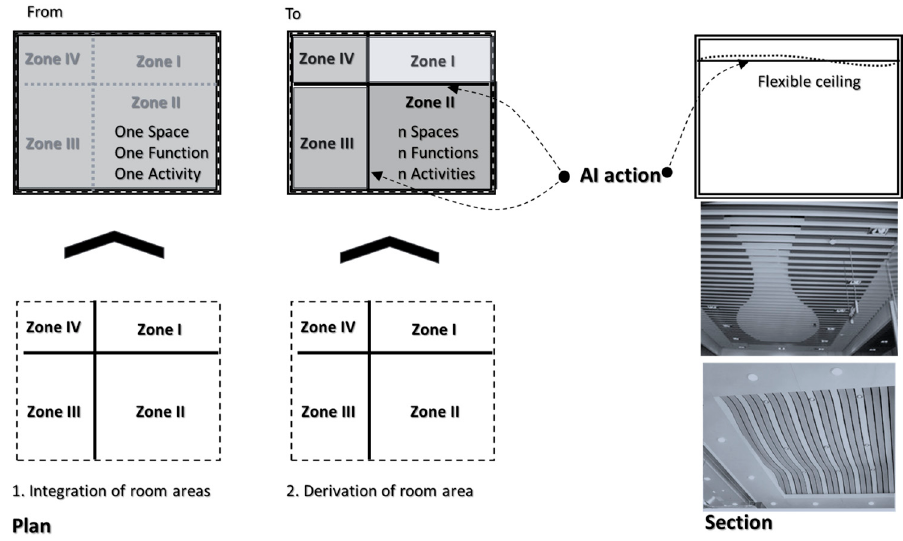
Figure 9. Rooms’ temperature comfort according to human activities and home zones.